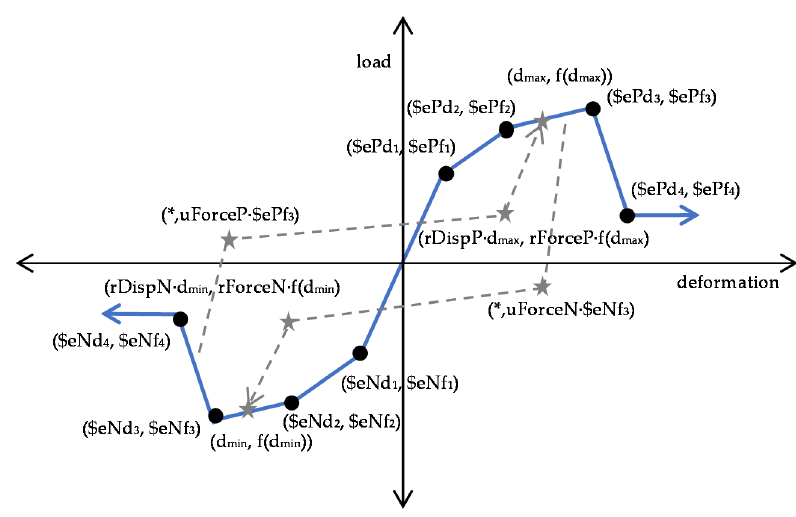
Figure 5. Pinching4 uniaxial material model [75].